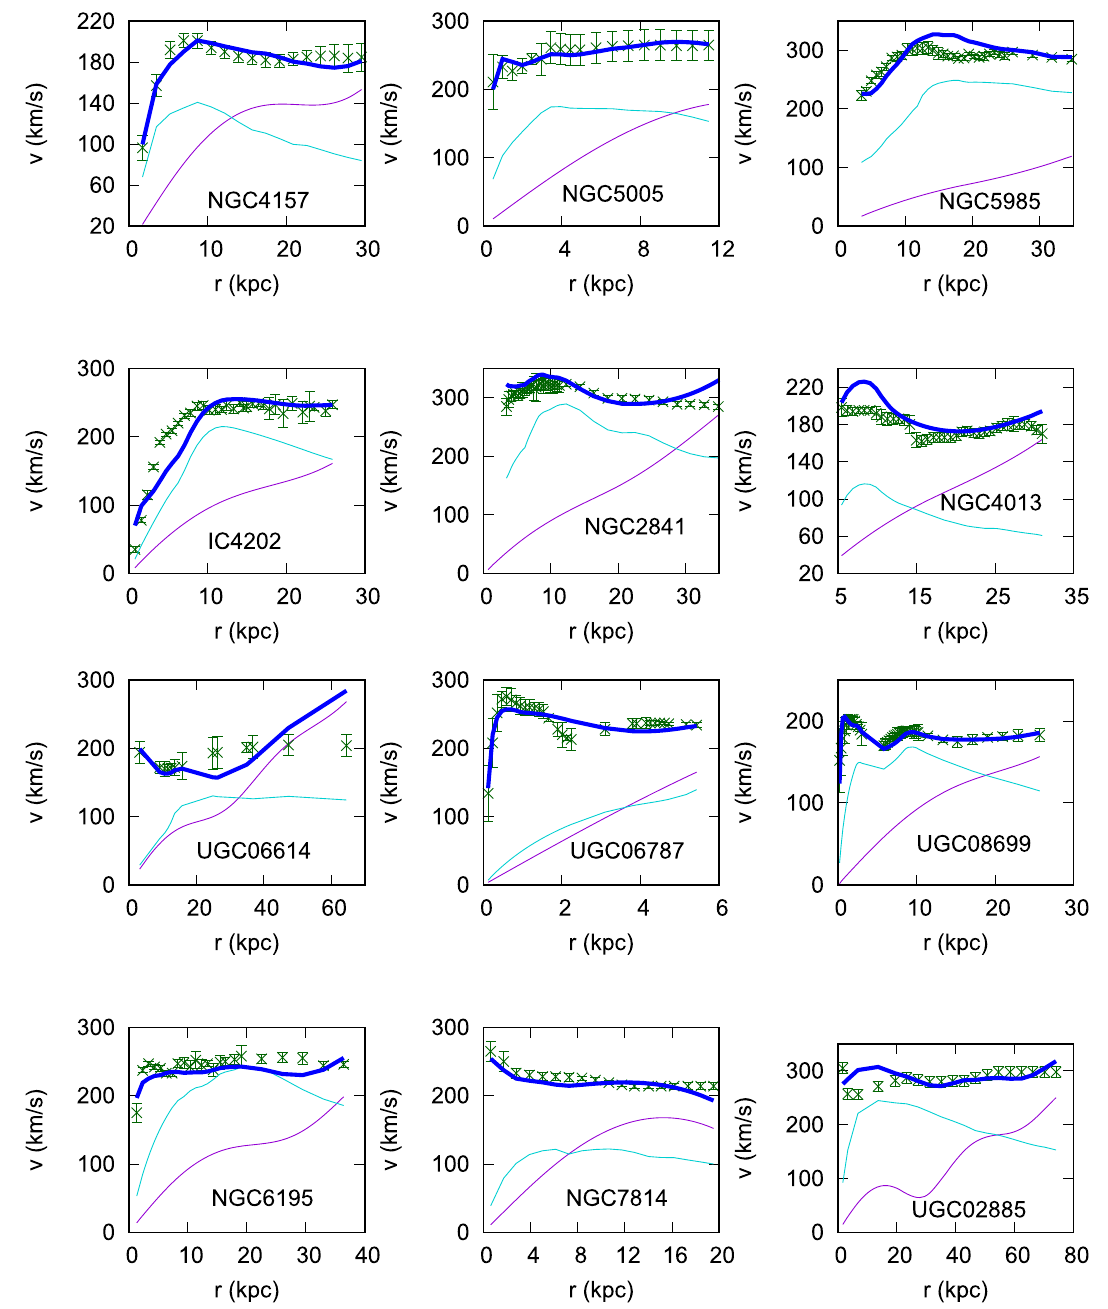
Fig. 10 Comparison of the theoretical predictions for the galactic rotation curves of the random Bose–Einstein Condensate dark matter model with constant static radius R with the observational data of 12 SPARC galaxies with bulge